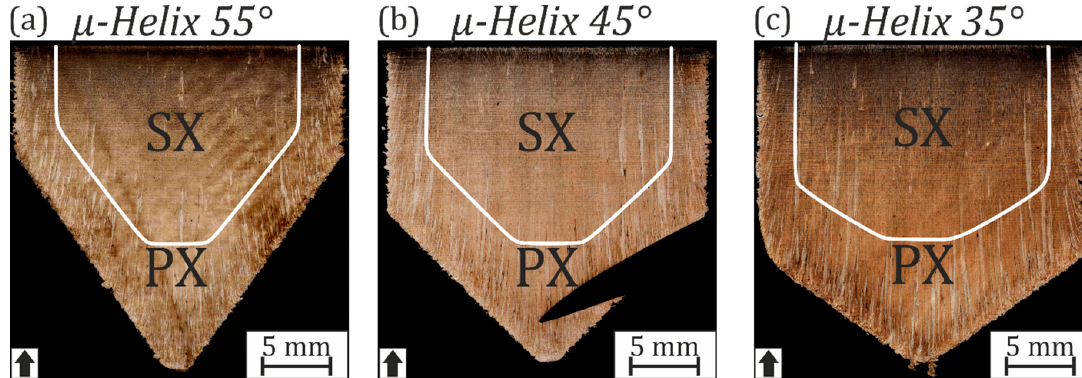
Figure 4. Macro-etched longitudinal sections from trapezoidal prisms manufactured with the µ-Helix parameter setting. The build direction is indicated by the black arrows. The aperture angle of ( a ) 55°, ( b ) 45° and ( c ) 35° in the wedge section influences the overall shape of the SX region (white), but the SX selection height of about 9 mm remains constant.